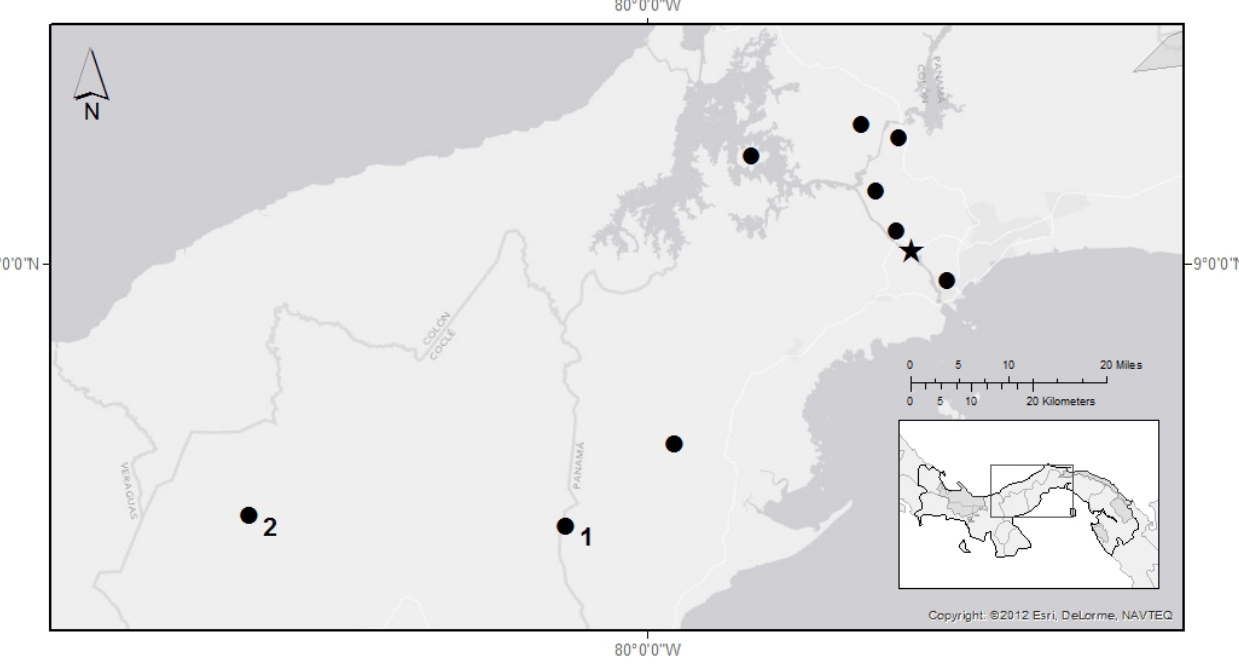
Trimetopon Map of